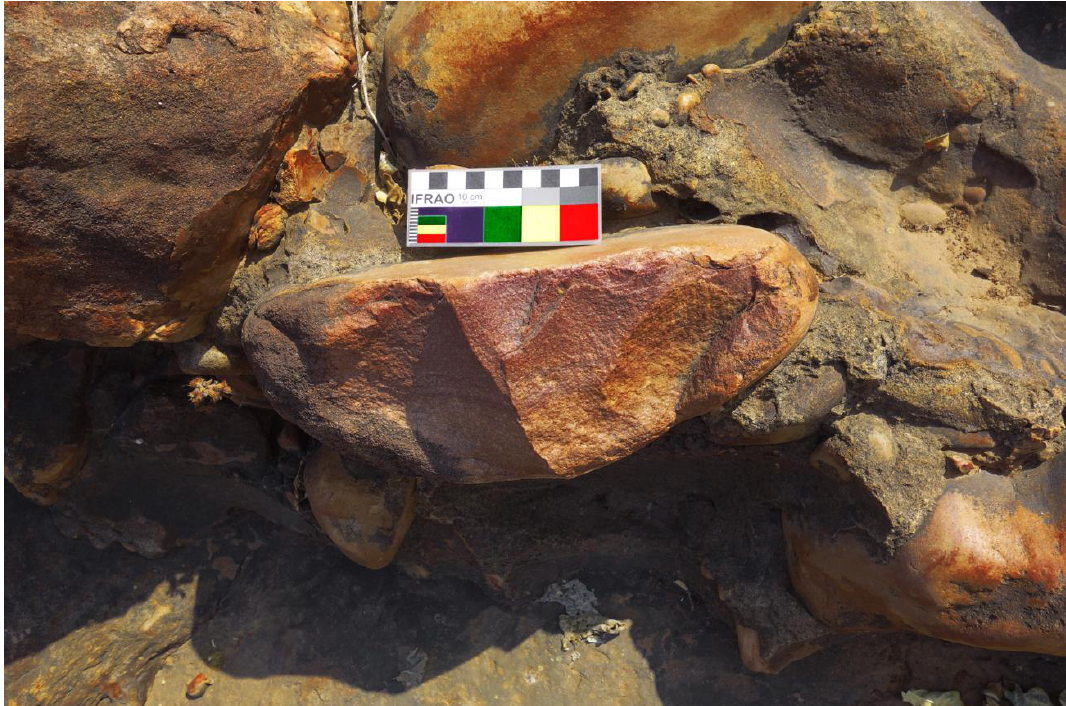
Figure 2. Large cobbles of the conglomerate immediately overlying bedrock, bearing KEM veneers. Eastern sector of the paleo-channel site at Indragarh Hill near